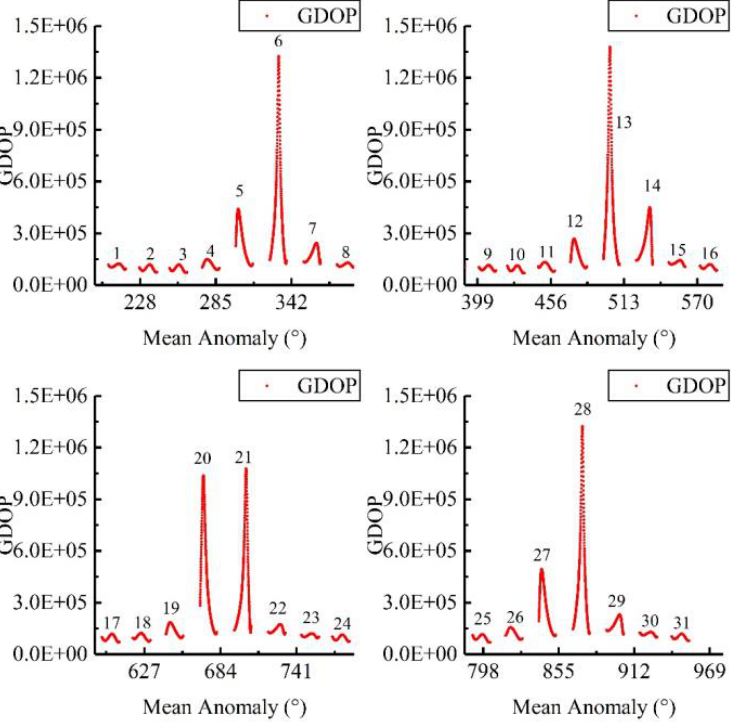
Figure 2. GDOP calculated by Equation (10) at different visible arc segments.